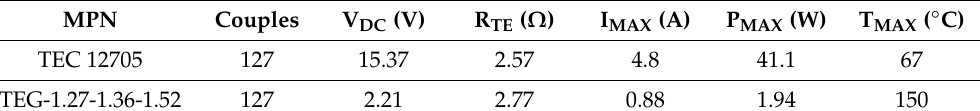
Table 1. Parameters of TEC-12705 and TEG-1.27-1.36-1.52 modules of TECooler.